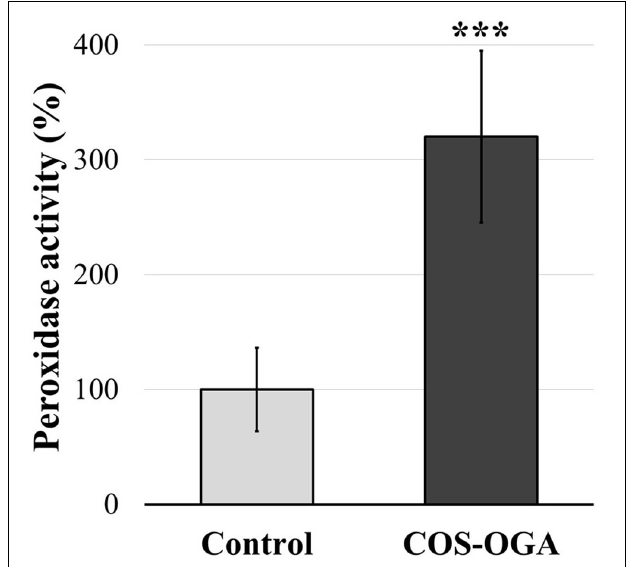
FIGURE 8 | Normalized apoplastic reactive oxygen species (ROS) production in tomato leaf disks. Tomato leaf disks were treated with 0.1% Tween 20 (control) or chitooligosaccharides–oligogalacturonides (COS-OGA; 62.5 mg/l). The average apoplastic ROS production of the COS-OGA-treated leaf disks is expressed as a percentage luminol chemiluminescence emitted in comparison to the control ± standard deviation ( n = 12). ***indicates a statistically significant difference to control according to Student’s t test ( p < 0.001, R